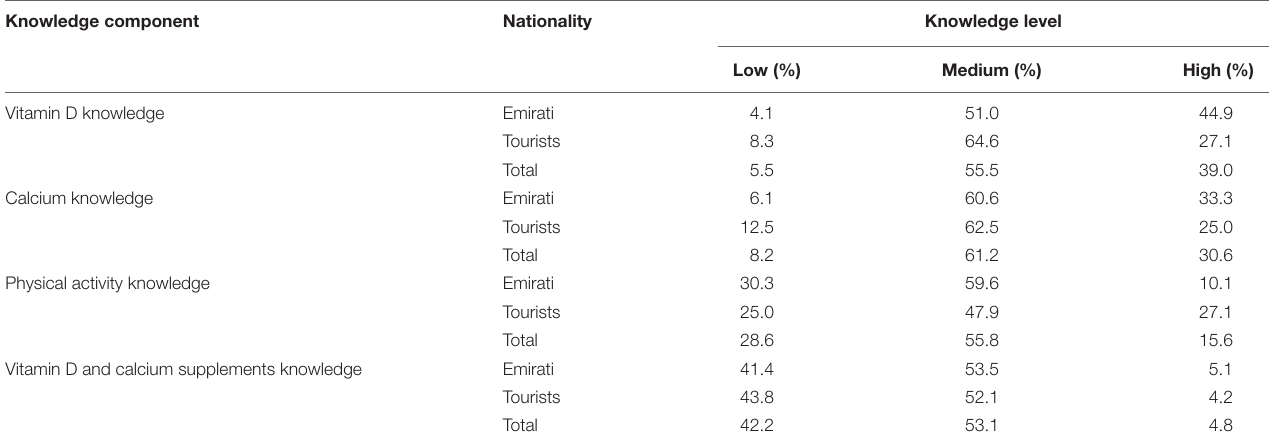
TABLE 2 | Comparison of knowledge level between Emirati and